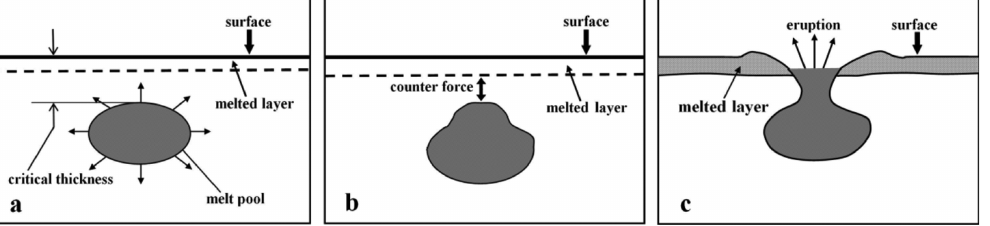
Figure 4: Ultrafine grains on the surface of pure zirconium trea- ted with (a) 1, (b) 5, (c) 10 and (d) 20 pulses, respectively.